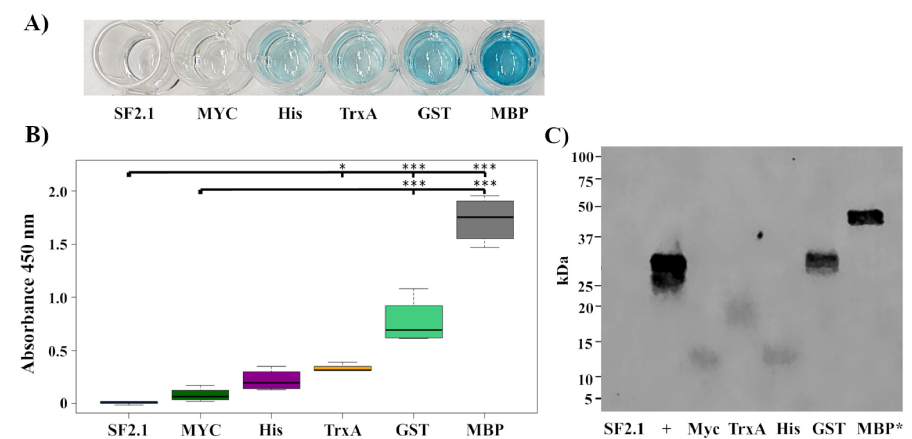
Fig 2. Antiplasmodial effector abundance in the supernatants from Asaia . (A) A representative ELISA that utilized anti-Myc primary and anti-mouse-HRP secondary antibodies to detect the presence of the recombinant protein in the supernatant fraction of transgenic Asaia strains. SF2.1, wild-type Asaia . (B) Quantification of supernatant fractions of the ELISA analysis. Relative levels (expressed as absorbance values measured at 450 nm) of substrate cleaved by the HRP-conjugate anti-mouse antibody across five separate trials. Statistical significance was determined using one-way ANOVA with Dunnett’s correction where significance is represented by � P < 0.05, �� P < 0.01, and ��� P < 0.001 with experimental replicates. SF2.1, wild-type Asaia . (C) Representative western blot of supernatants from antiplasmodial Asaia strains. SF2.1, wild-type Asaia ; +, pIT2-scFv Myc positive control; MBP � , MBP diluted to a final OD 600 of 10.